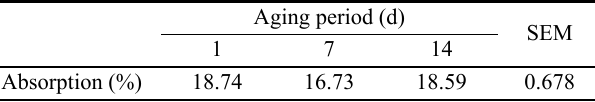
Table 1. Effect of aging on marination absorption (%) of